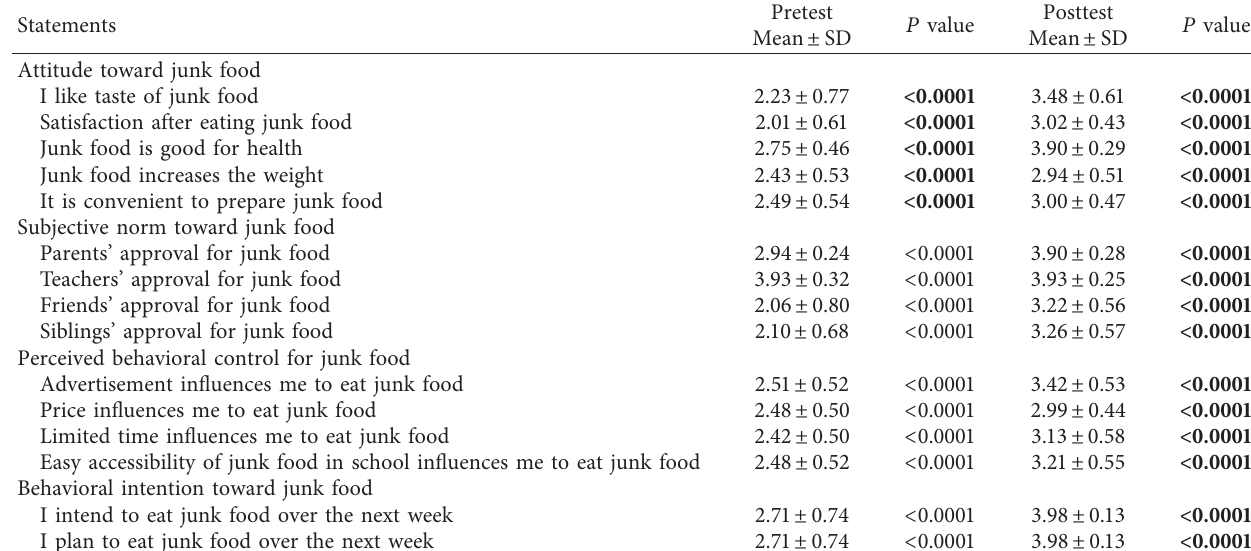
Table 2: Constructs of theory of planned behavior toward junk food consumption.